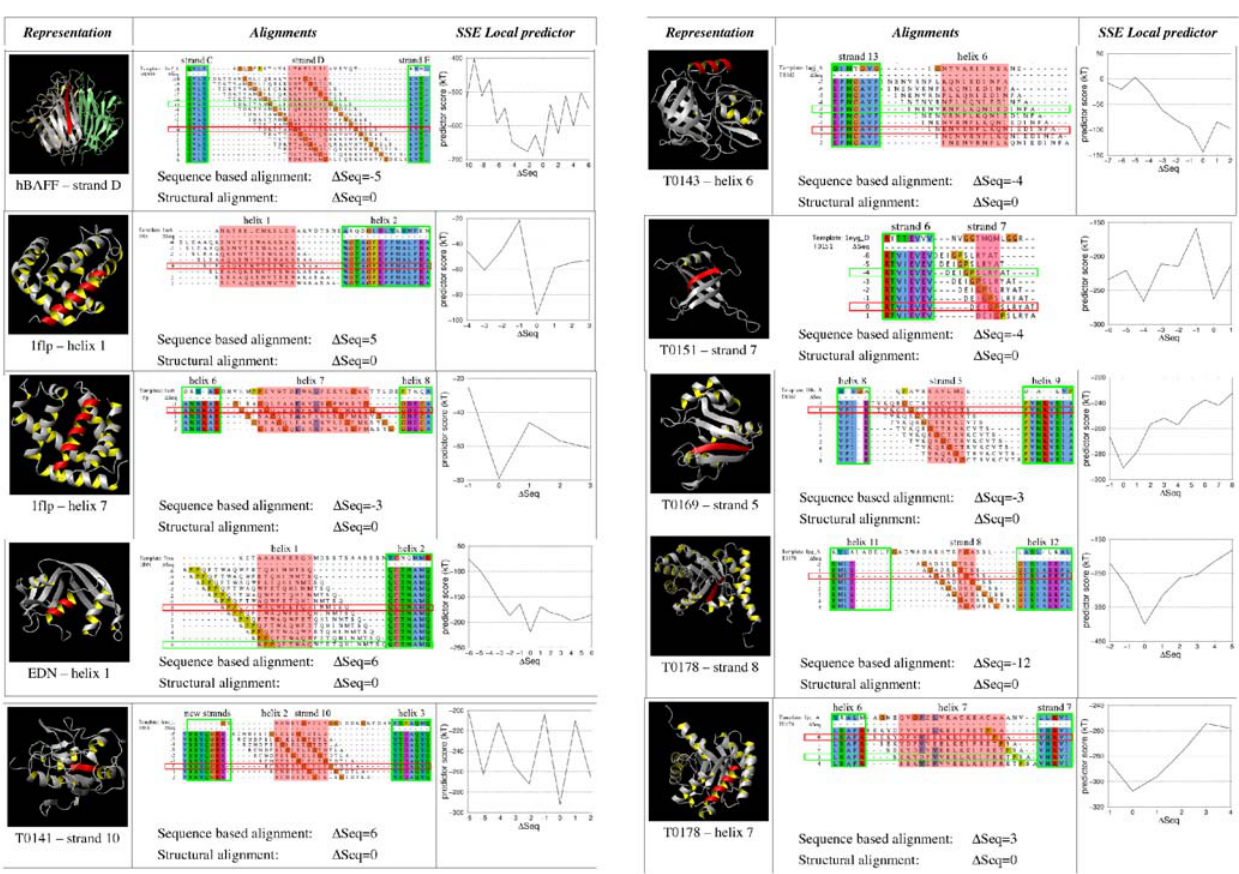
Figure 3. For each test case, the SSE in the ROI is colored in red on a protein ribbon representation and is defined by a red rectangle in the alignments. The different alignments are represented and the corresponding score using the ANOLEA/SSE Local predictor is plotted. In T0141 test case, the ‘‘new strands’’ label in the alignment picture represents the position of a beta finger present in the structure of T0141 but absent in the 1aro_L template.